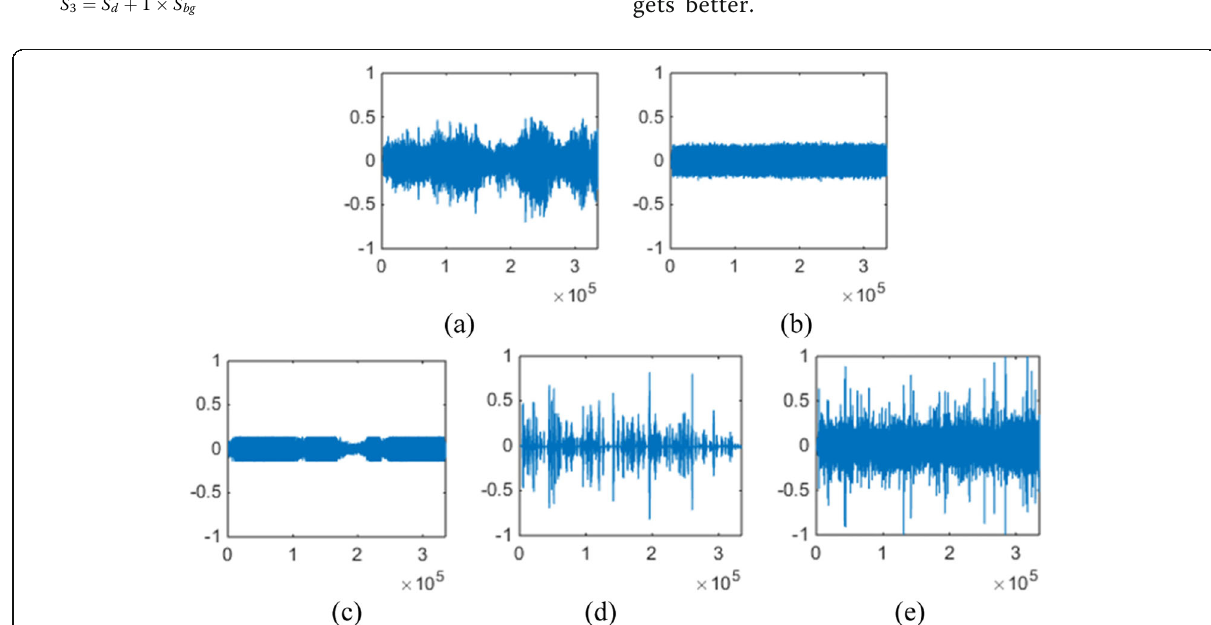
Fig. 16 Amplitude spectrum after normalization: a drone, b plane, c car, d bird, and e rain